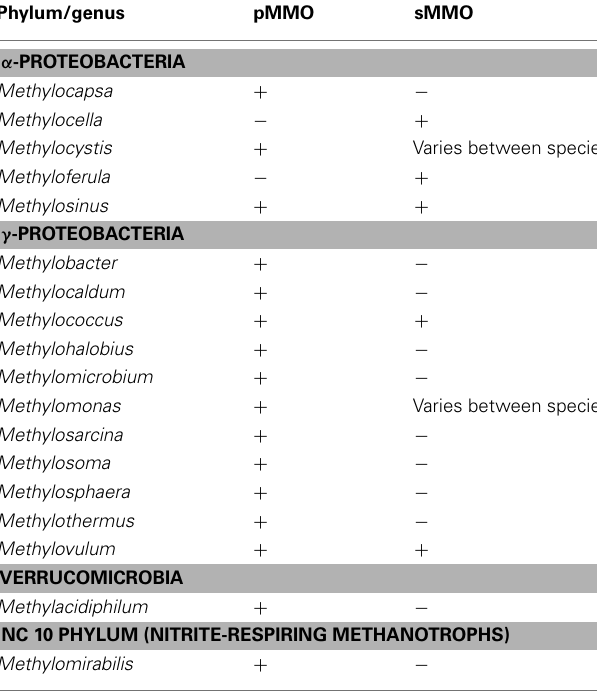
Table 2 | Halogenated hydrocarbons degraded by sMMO. Compound